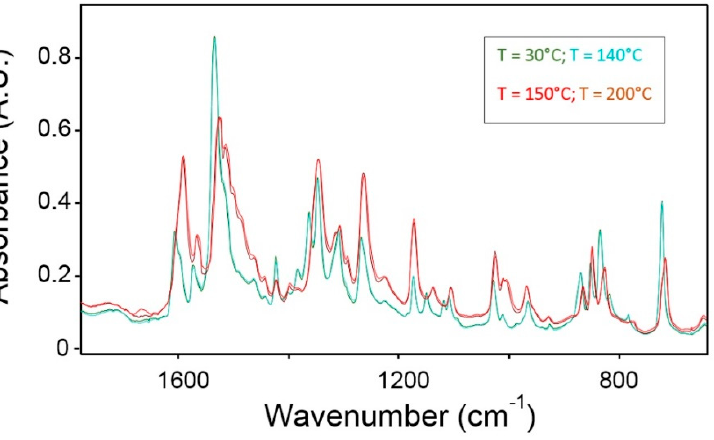
Figure 8. FTIR spectra of Ac2 in the frequency range 1700–600 cm − 1 collected at 30 °C (green trace), 140 °C (turquoise), 150 °C (red) and 200 °C (light brown).